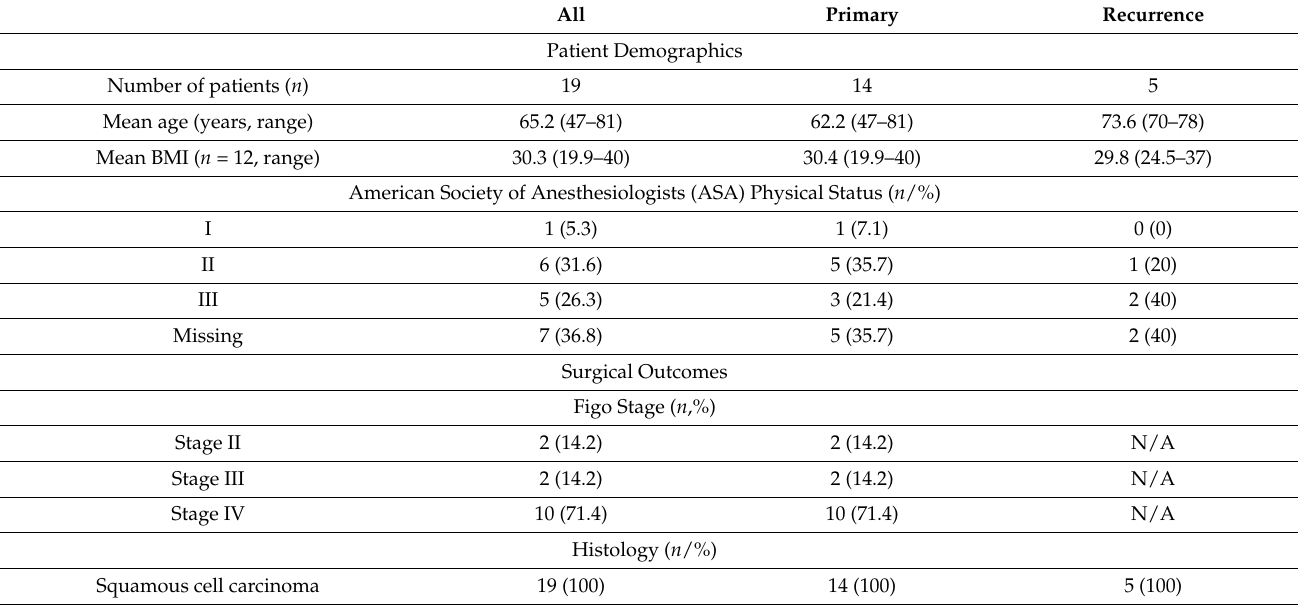
Table 1. Baseline characteristics, procedures and